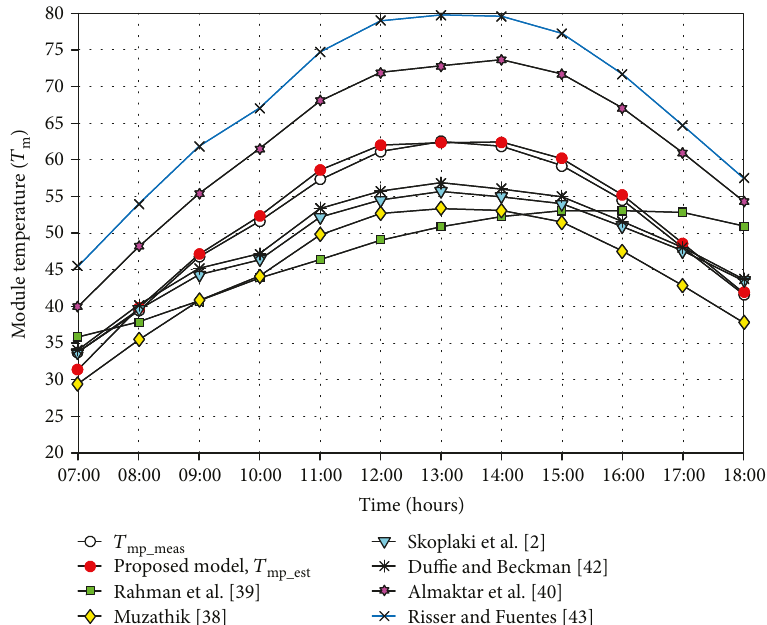
Figure 12: Proposed model estimation versus measured data and other existing model module temperature values of polycrystalline module during summer.